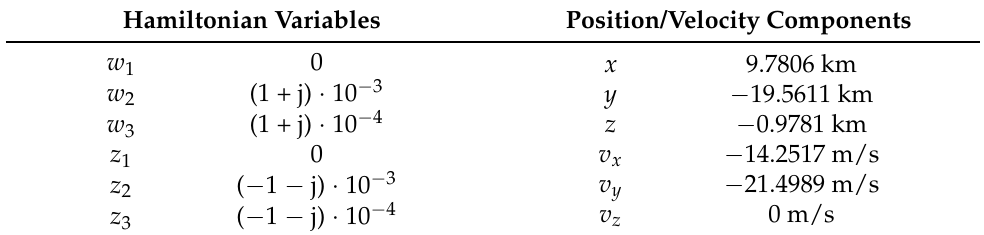
Table 2. SSO formation: initial state of deputy